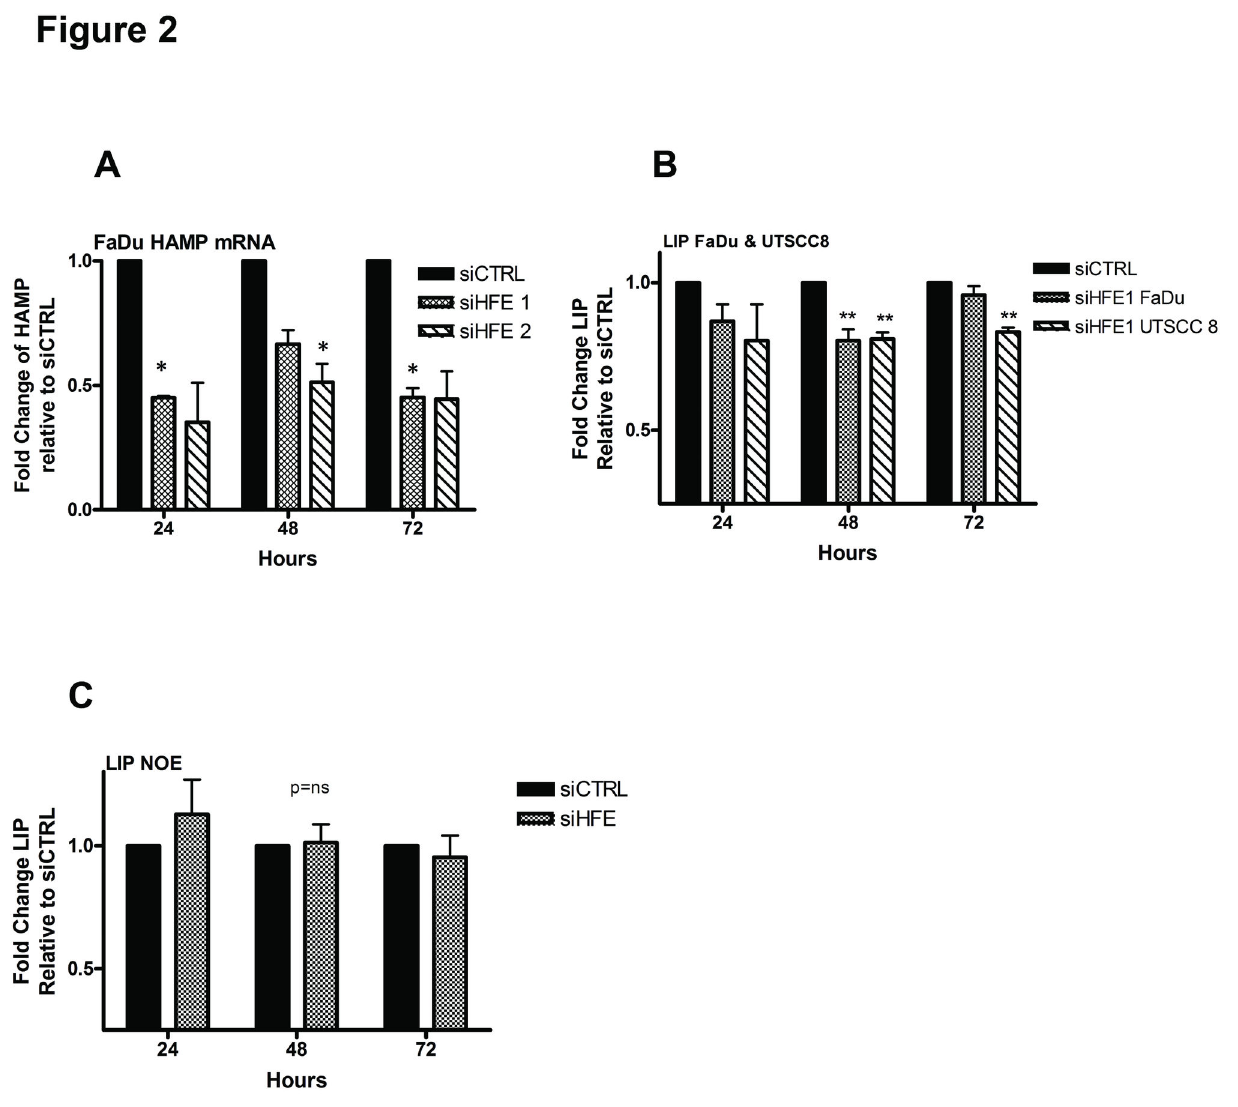
Figure 2. HFE regulates cellular iron. (A) qRT-PCR of HAMP levels at 24, 48 and 72 hrs post-transfection with 20 nM each of siHFE1, or siHFE2, relative to fold-change in siCTRL-treated cells. (B) Cellular labile iron pool (LIP) in FaDu and UTSCC8 cells transfected with 20 nM each of siCTRL or siHFE, detected by flow cytometry with calcein-AM at 24-72 hrs post-transfection. (C) Cellular LIP of NOE cells transfected with 20 nM of siCTRL or siHFE, detected by flow cytometry with calcein-AM at 24-72 hrs post transfection. *P<0.05, **P <0.005, P=ns (not